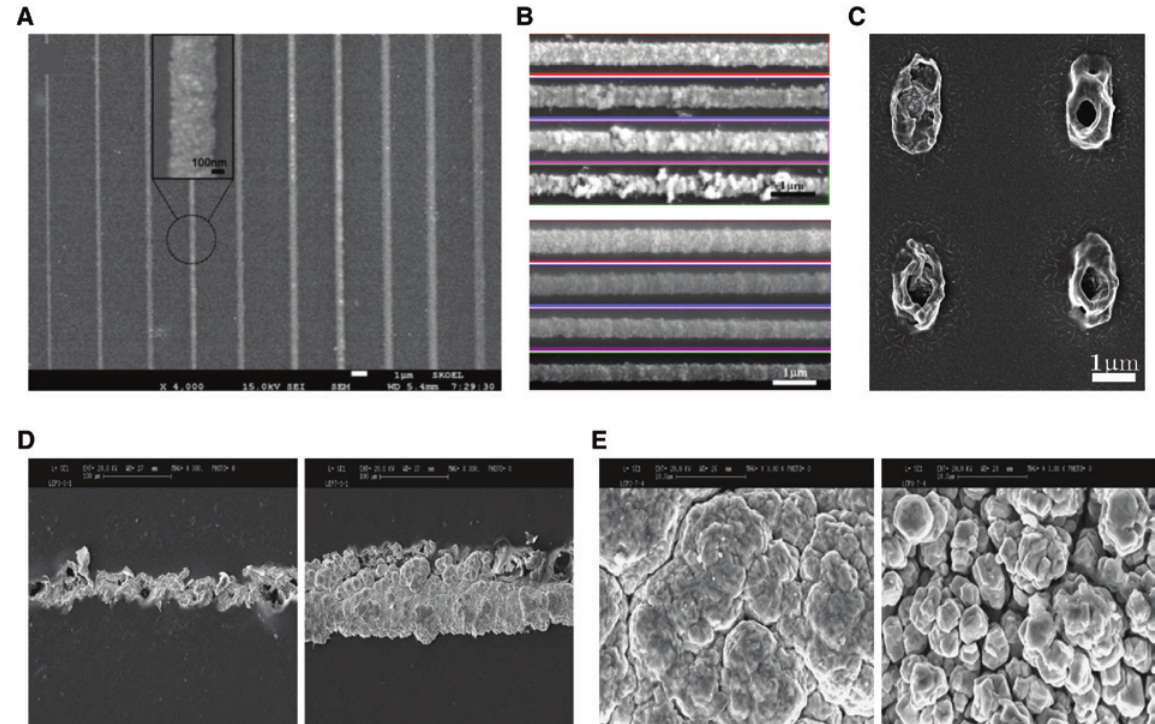
Figure 6: 2D metallic